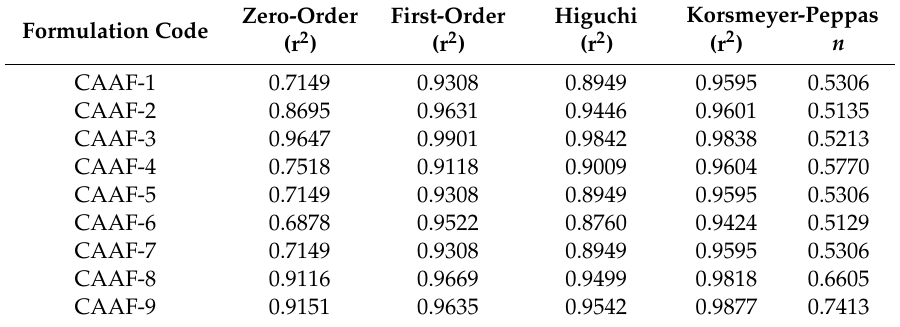
Table 1. Kinetic modeling release of diclofenac sodium (DS) from the Car934-g-poly(acrylic acid) hydrogels. Zero-Order First-Order Formulation Code (r 2 ) (r 2 )